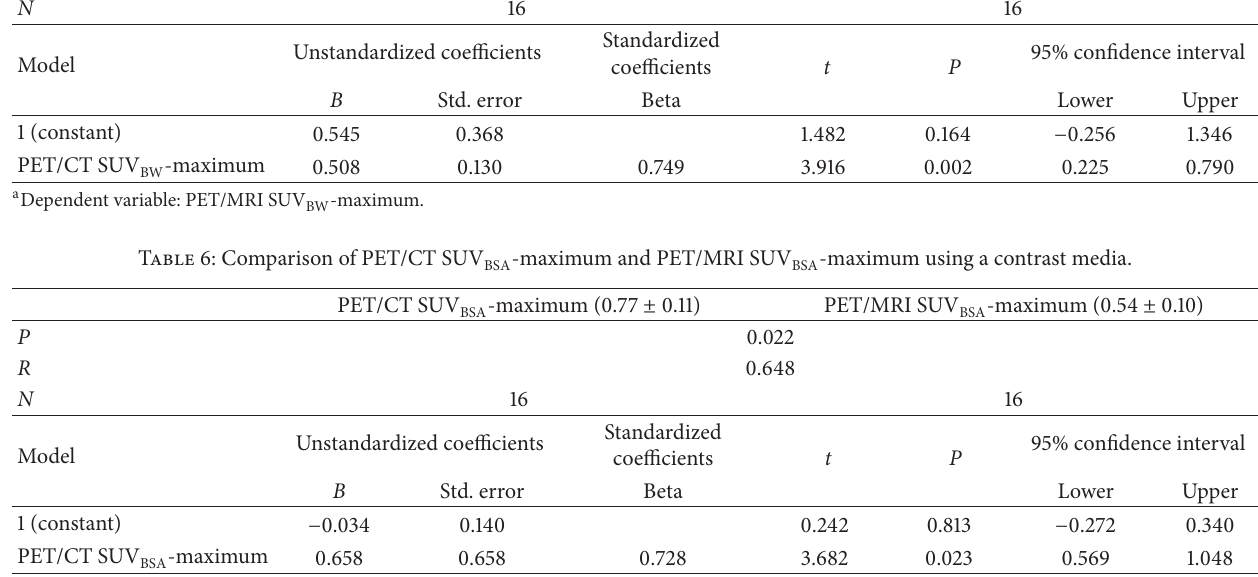
-maximum using a contrast media. BW